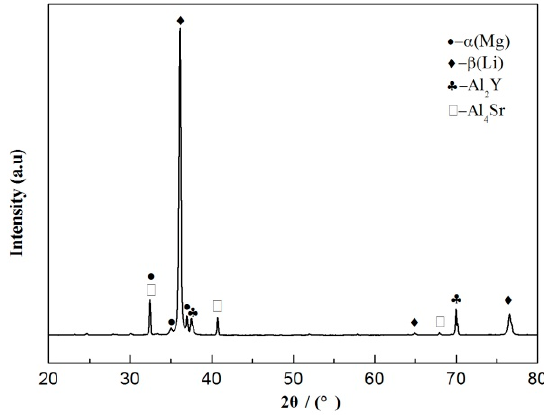
Figure 1. The XRD results of Mg-9Li-3Al-2Sr-2Y alloy.